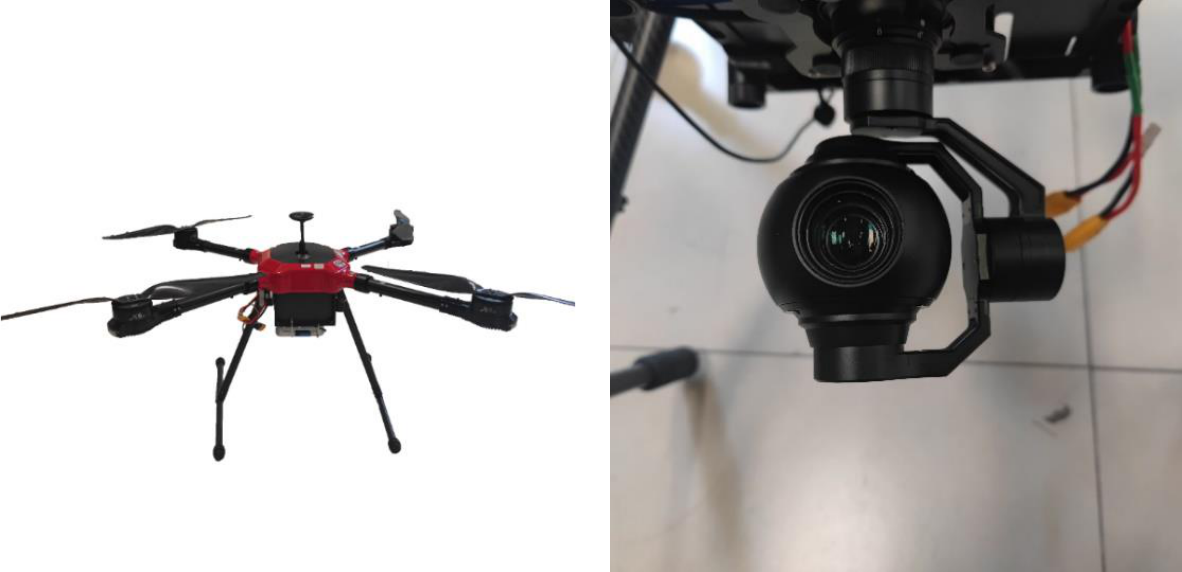
Figure 9. The multirotor X-type tethered UAV and pan – tilt – zoom camera.